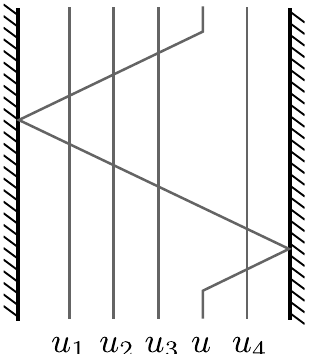
Figure 19 . A pictorial explanation of the boundary Bethe equation. When a magnon moves along the chain and comes back to its original position, it scatters with other magnons twice (in the opposite directions) and also gets re(cid:13)ected at the boundaries. The phase shift in this process is given by the right hand side of